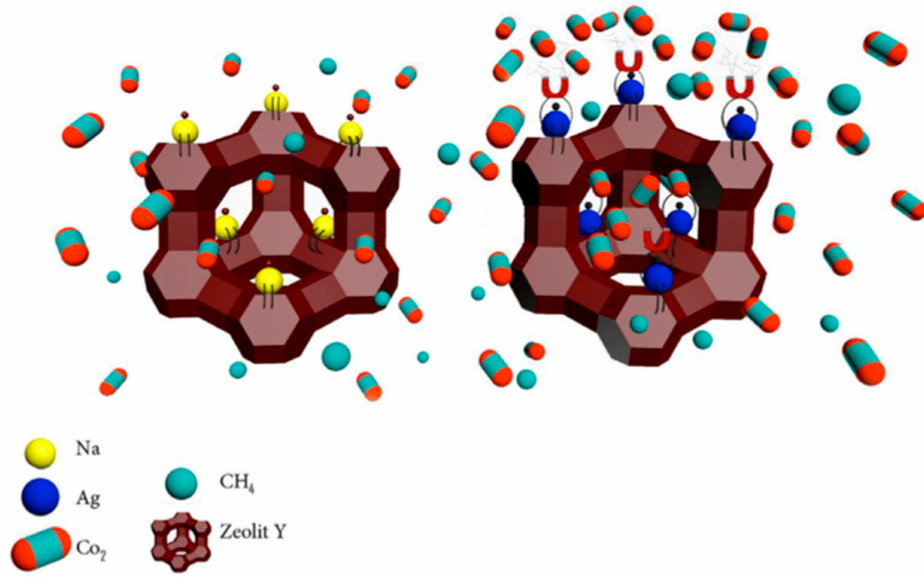
Figure 7. Schematic drawing of the CO 2 -facilitated transport through the modified zeolite-Y